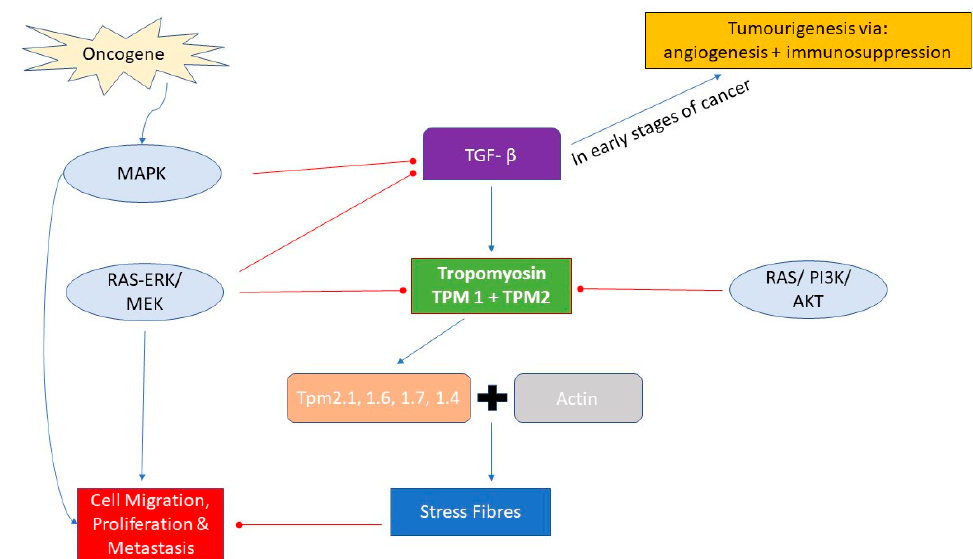
Figure 1. Cellular pathways involved in regulation of TPM binding with actin to form stress fibres to stabilize cellular structure and prevent cell motility.